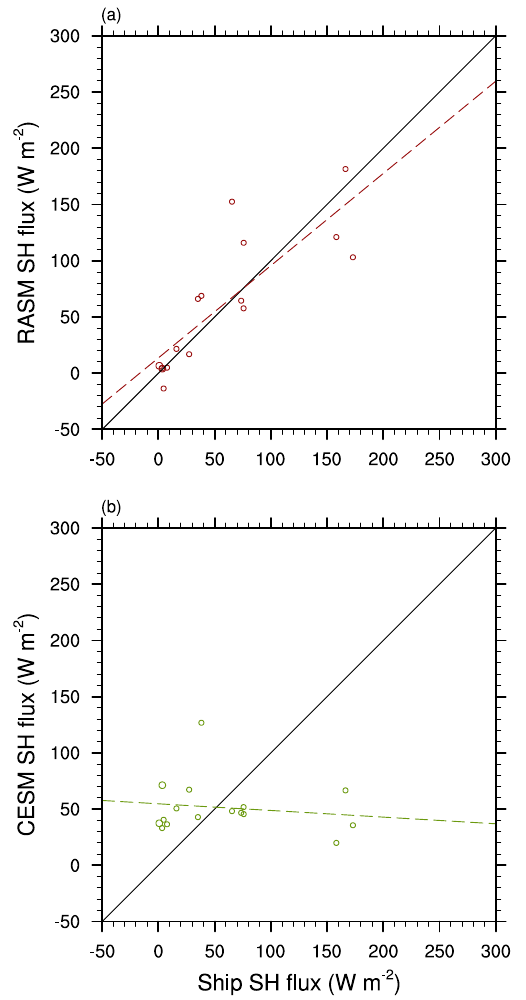
Figure 15. Daily mean model ( a RASM1; b CESM1) SH fluxes compared to corresponding observed fluxes aboard ship cruises in the North Pacific and Atlantic. The one-to-one line is indicated by the black line, and the dashed lines are the linear regressions of the model to ship fluxes.